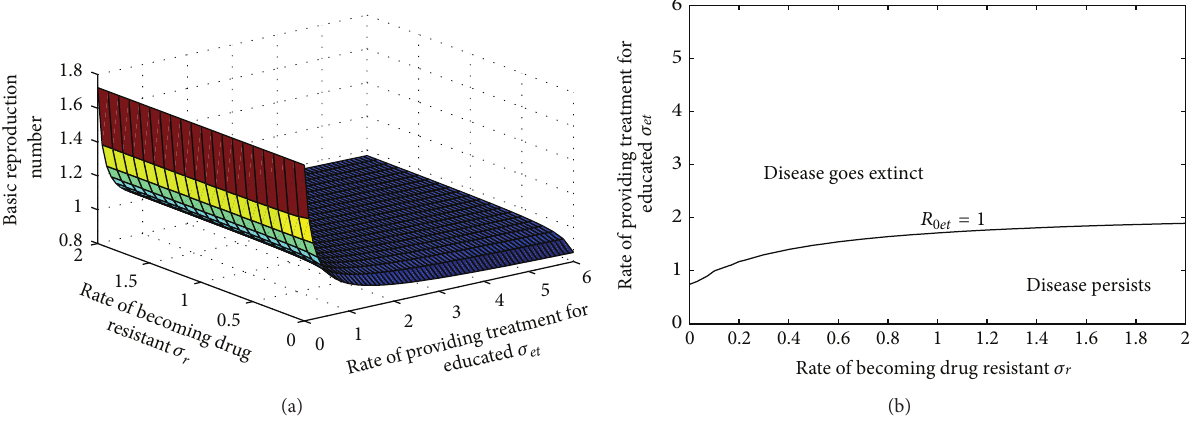
Figure 4: (a) The basic reproduction number for the test and treat with drug resistance and obligatory education model (55) as a function of two variables: the rate of becoming drug resistant 𝜎 𝑟 and the rate of providing treatment for educated individuals 𝜎 𝑒𝑡 . (b) The projection of the surface 𝑅 0 𝑒𝑡 = 1 on the plane (𝜎 𝑟 , 𝜎 𝑒𝑡 ) . With sufficient education, the disease can be